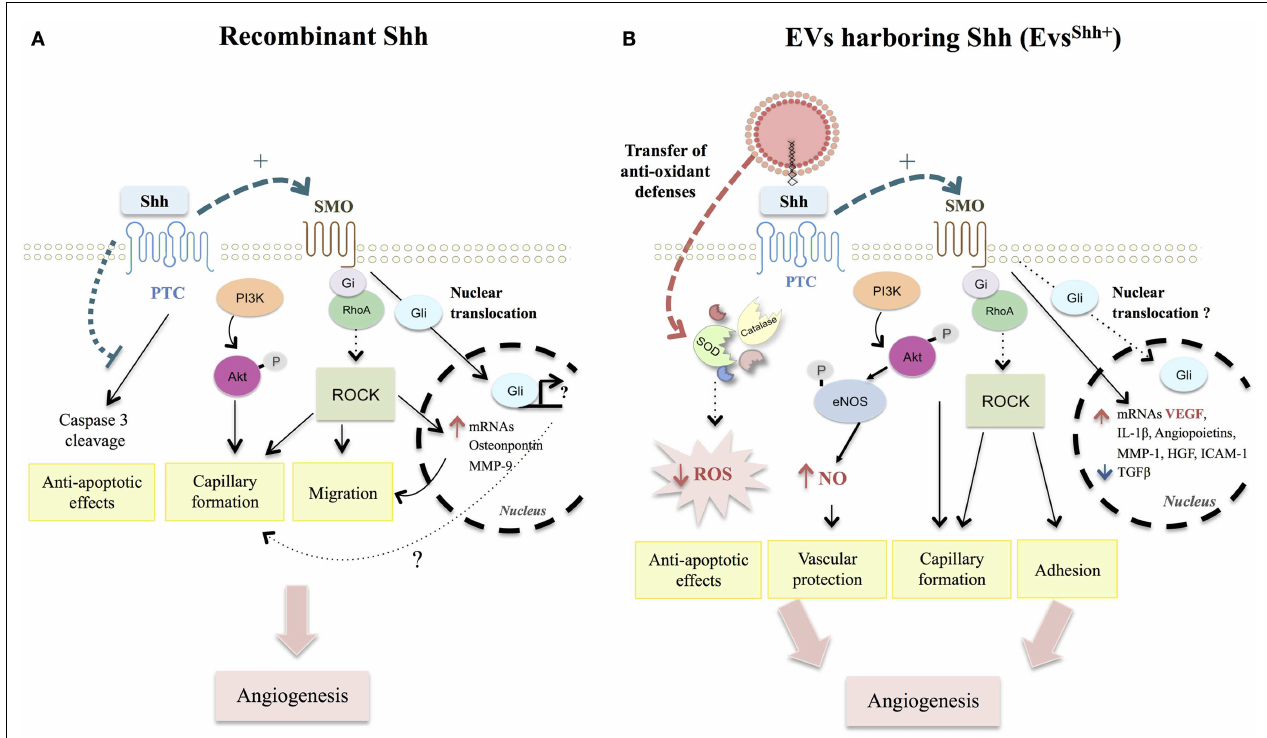
FIGURE 2 | Comparison between recombinant Shh- and EVs Shh + -activated pathways modulating angiogenesis and apoptosis in endothelial cells . (A) Recombinant Shh protein was shown to promote migration and capillary formation through SMO-Gi coupled and PI3K activation, triggering ROCK pathway activation, and downstream targets (MMP-9 and osteopontin). Such activation illustrates the importance